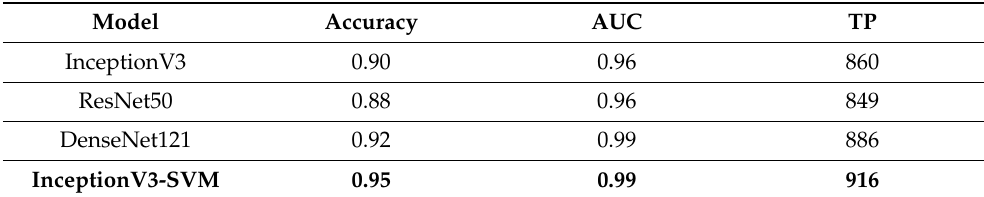
Figure 4. AUC-ROC curve of the DCNN models: ( a ) InceptionV3; ( b ) ResNet50; ( c ) DenseNet121; and ( d ) Proposed InceptionV3-SVM .